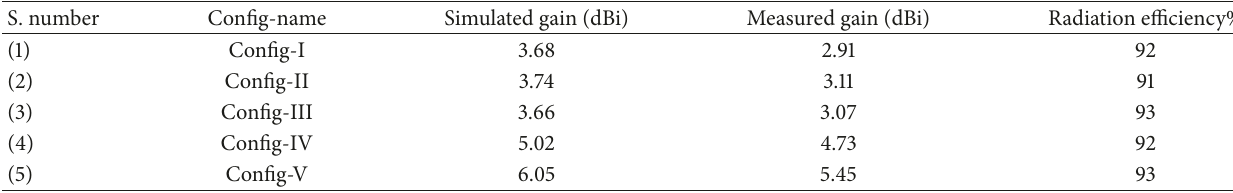
Table 4: Simulated and measured gain and radiation efficiency of the proposed FR